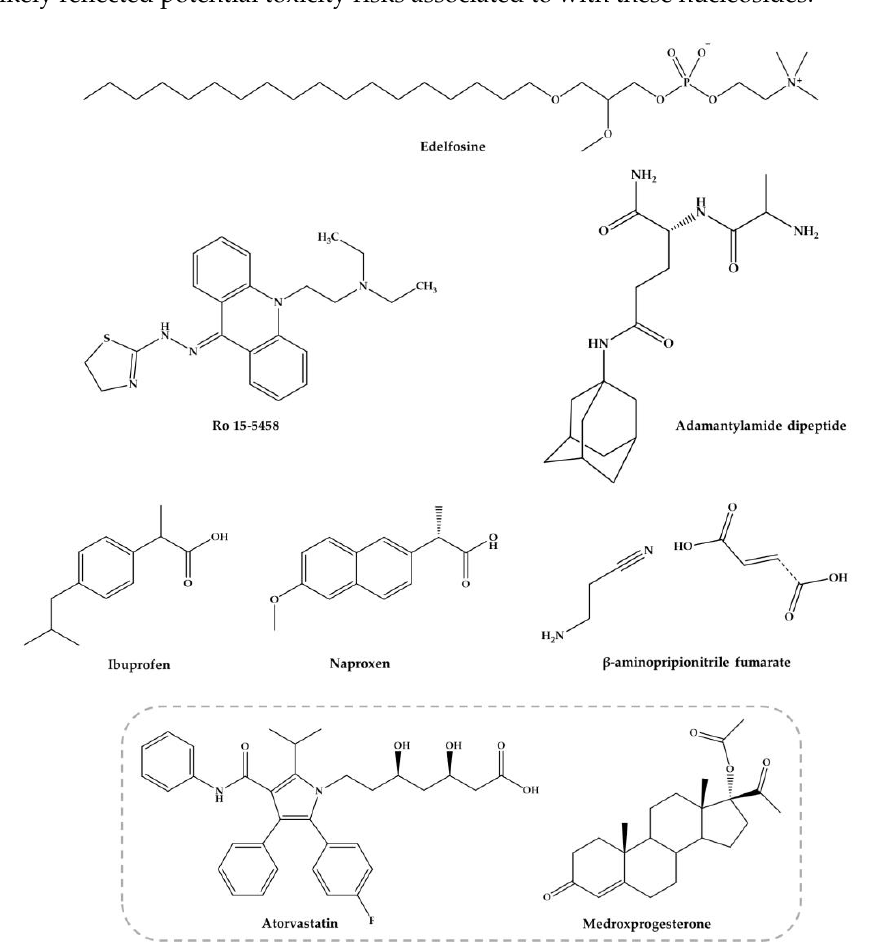
Figure 4. Several compounds within different properties against experimental S. mansoni